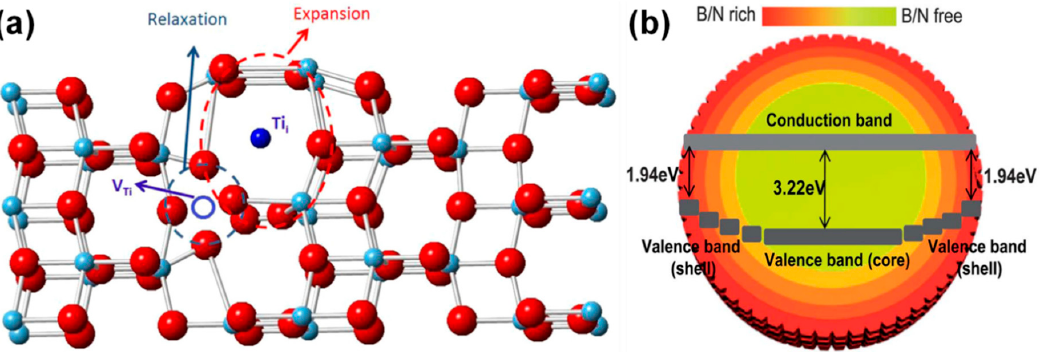
Figure 19. ( a ) Structure of yellow-TiO 2 and ( b ) anatase red TiO 2 via gradient B-N co-doping (reproduced with permission from refs. [237,238]).